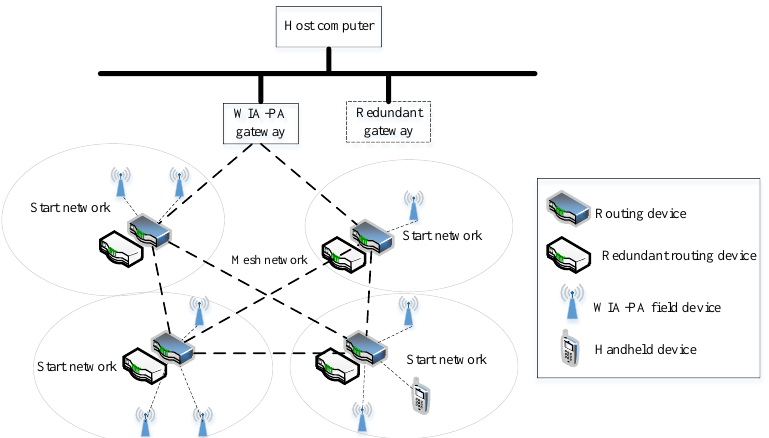
Figure 1. WIA-PA network topology.